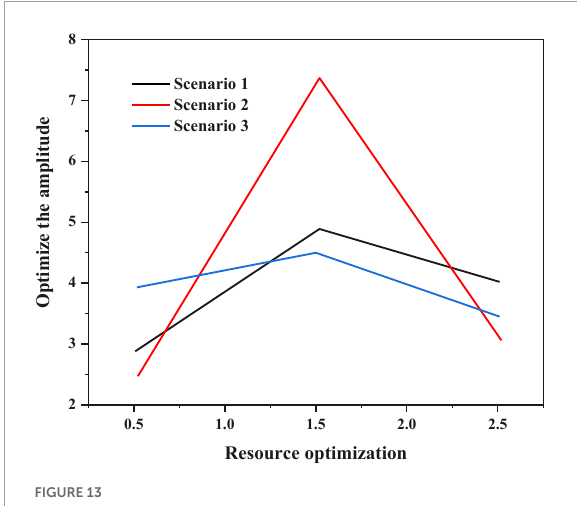
FIGURE13 Absolute values of w-e-f resource optimization results under three